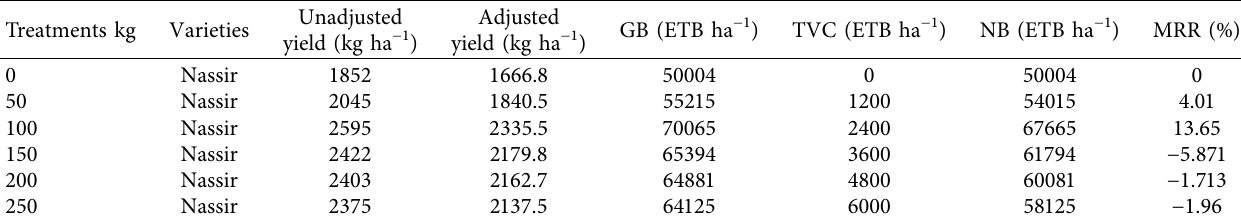
Table 8: Marginal analysis of common bean variety as infuenced by blended fertilizer rates. Treatments kg